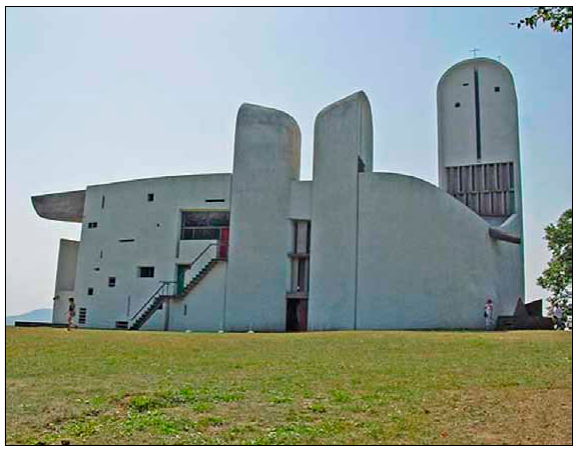
fig. 1. The chapel of notre Dame du Haut,